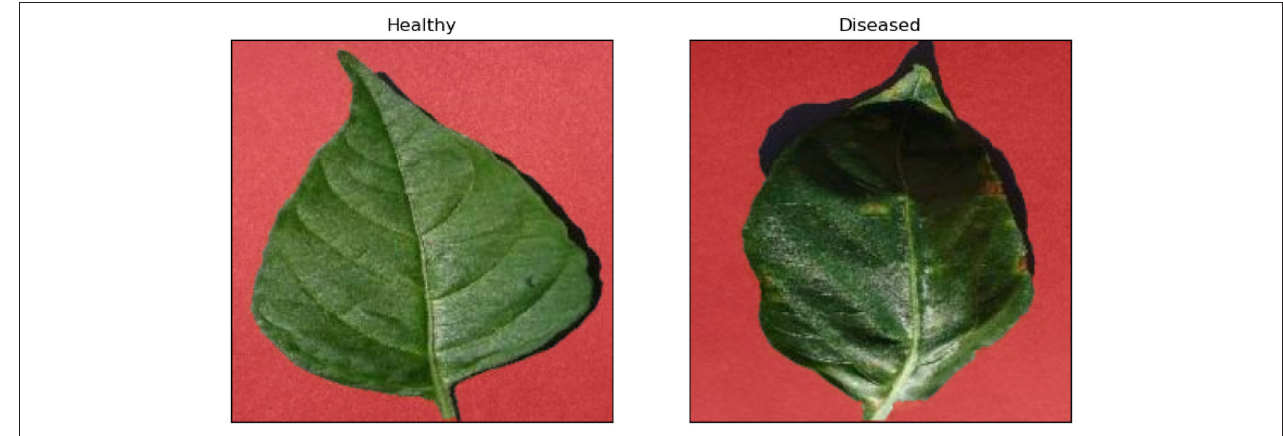
FIGURE 5 | Examples of the real masks of the healthy leaf and the diseased leaf. The labeled pixels in masks are red.